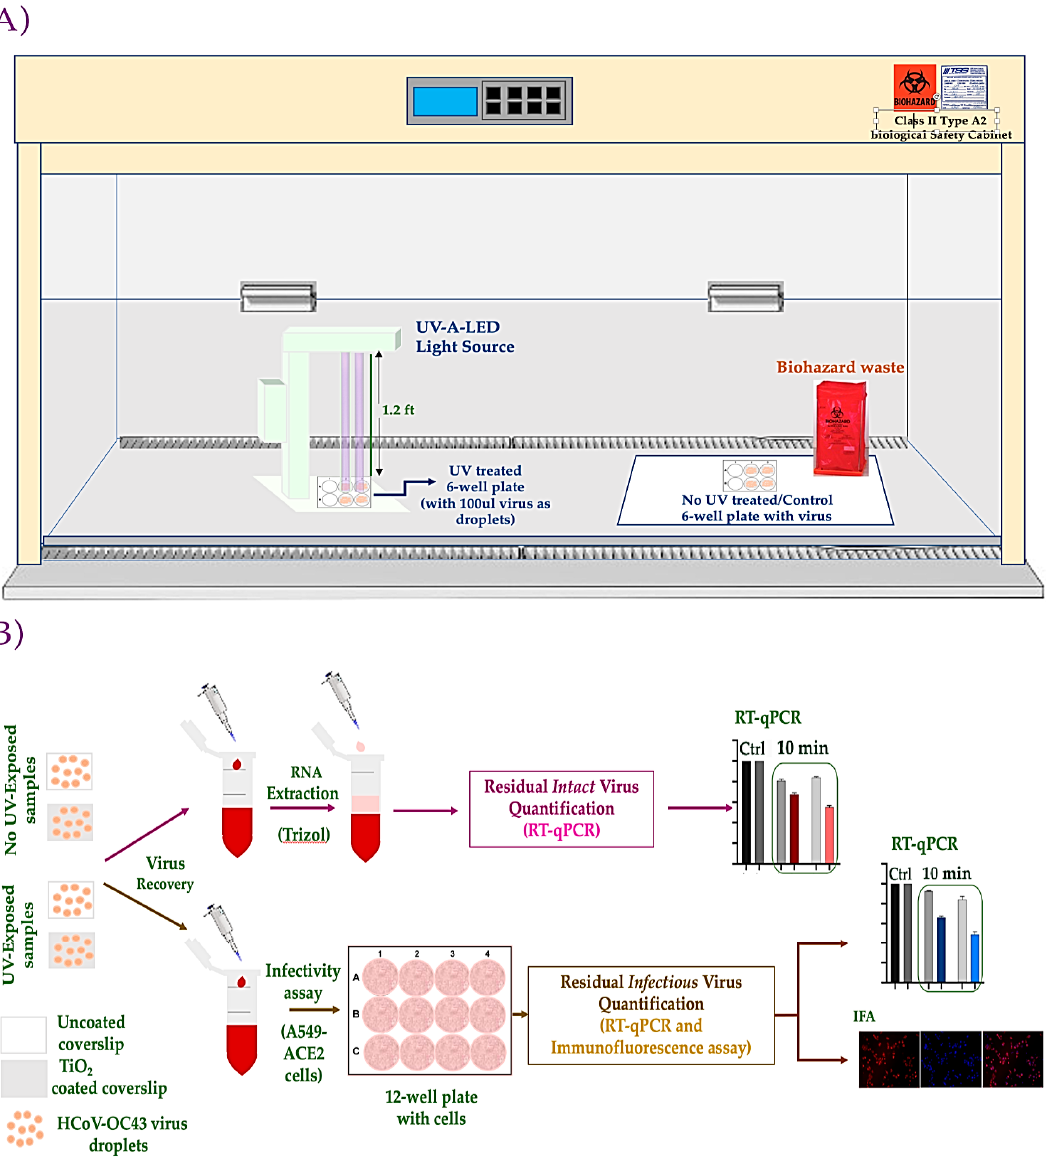
Figure 1. Schematic of the experimental set-up. ( A ) UVA LED-12V-367nm (MA-717836-1) light source was used for the inactivation of the HCoV-OC43 virus inside the biological safety containment facility (BSL-2). ( B ) The control and UVA LED-12V-367nm-treated viruses were collected to determine viral inactivation using RT-qPCR and immunofluorescence